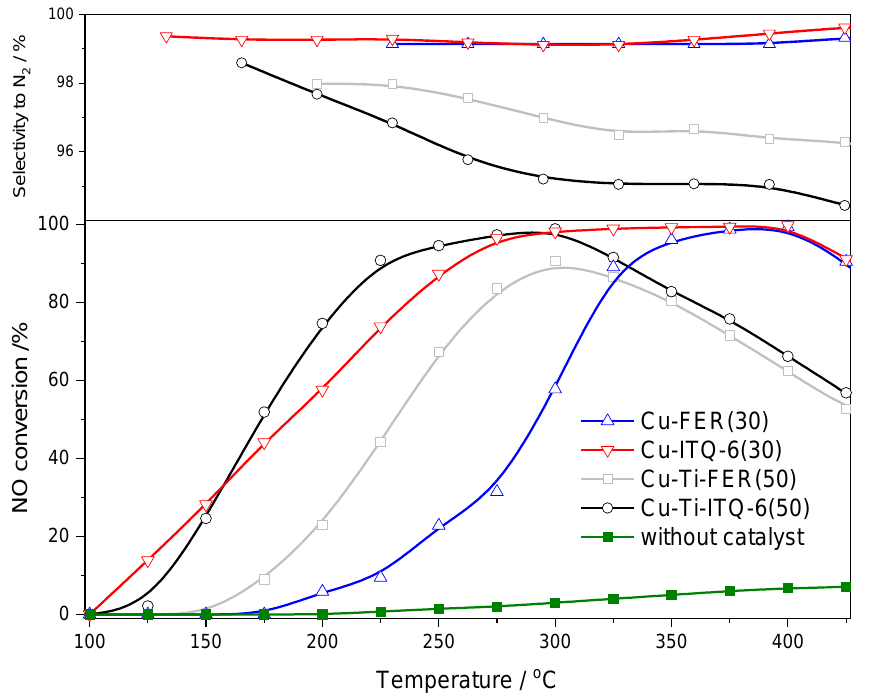
Figure 7. Results of NH 3 -SCR catalytic tests for aluminum–silicon (FER) and titanium–silicon (Ti- FER) ferrierites and their delaminated forms, ITQ-6 and Ti-ITQ-6, respectively, modified with copper via ion exchange method. Reaction conditions: 0.1 g catalyst, [NO] = [NH 3 ] = 2500 ppm, [O 2 ] = 2.5%, He = balance, total flow rate = 40 mL min − 1 , and GHSV = 12,500 h − 1 . Values in brackets are intended molar Si/Al or Si/Ti ratios in the zeolite framework. Based on the results presented in [7,34] with permission from ref. [34]. Copyright 2021 The Royal Society of Chemistry.